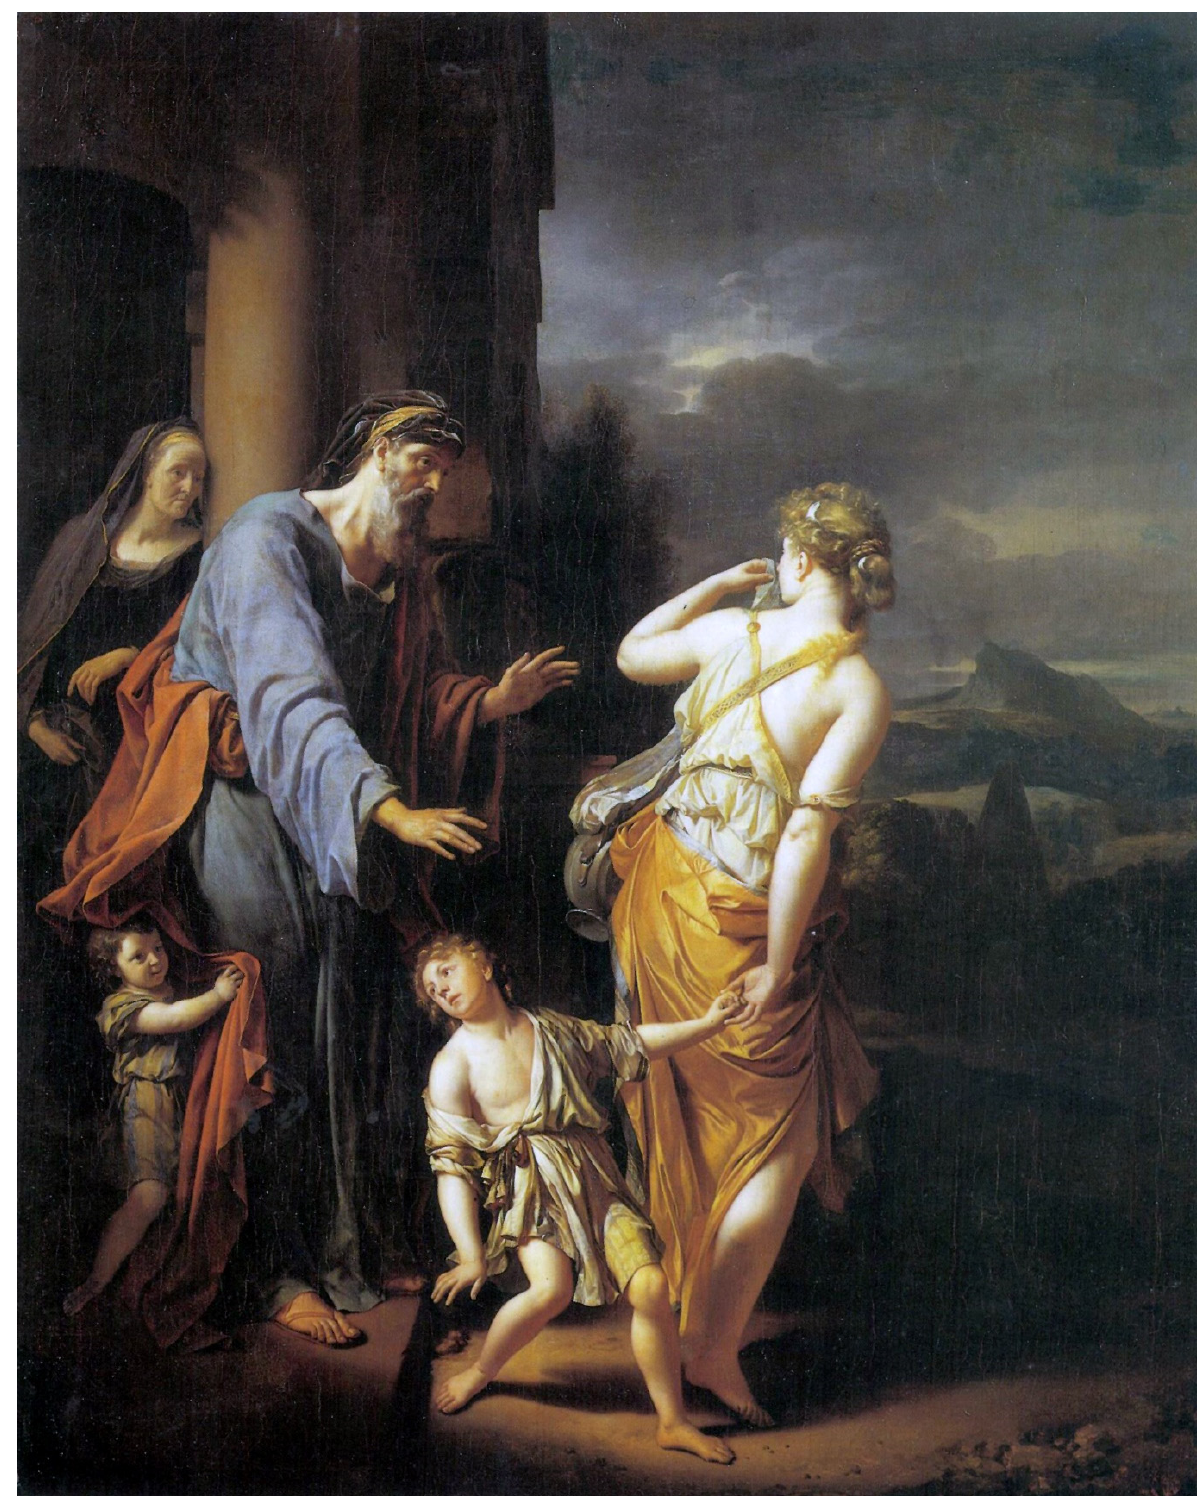
Figure 16. Adriaen van der Werf, ca. 1696. Dresden, Gemäldegalerie Alte Meister, n. 1823. The most outstanding cases are to be found in Italian art, with notable differences compared to the north from an iconic point of view. The artists concentrate more on the characters than on the description of the scene, presenting the drama in a more declamatory tone, while not leaving out the psychological nuances. A follower of Francesco Ruschi (London, Sotheby’s, 8-12-2916) 26 constructs a scene that is more rhetorical and gestural